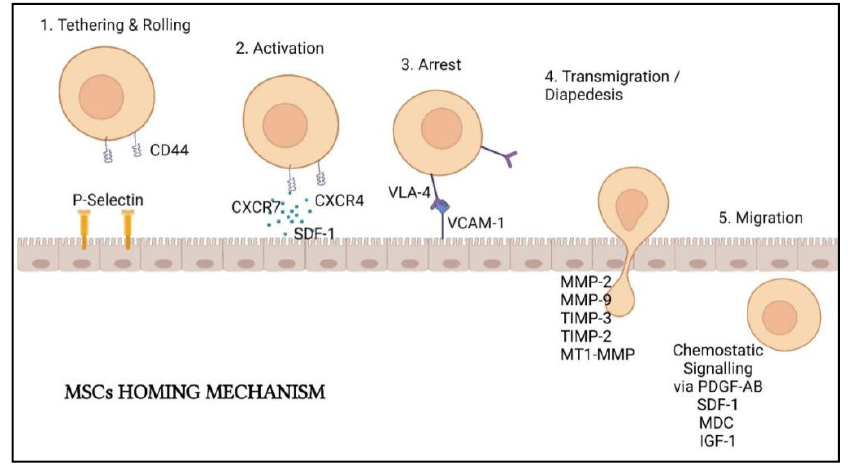
Figure 3. MSCs homing mechanism and involved biomolecules. Created with